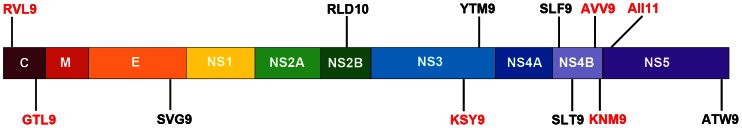
Location of A*11:01 (red) and A*02:01 (black) WNV peptide epitopes on the WNV polyprotein.C, nucleocapsid; M, membrane; E, envelope glycoprotein; NS, nonstructural.